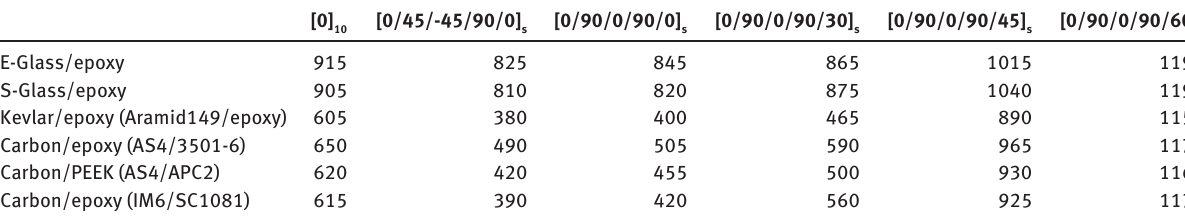
Table 5 Comparison of the critical loads P (N) obtained from meshfree methods (nodes: 11 × 19).